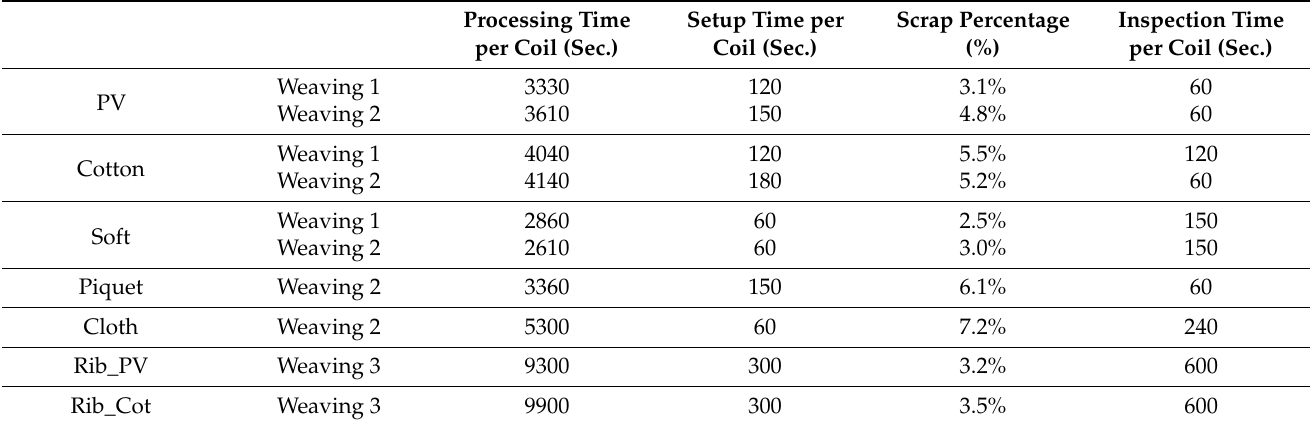
Table 3. Weavings’ data.